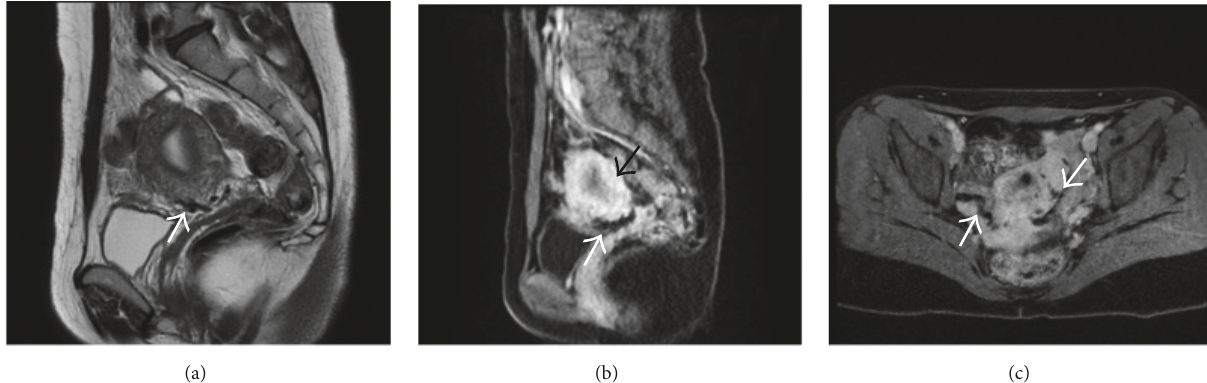
Figure 3: Postoperative MR 30 days after the embolization. (a) T2-weighted MR in sagittal plane: uterine wall preservation with serpiginous Onyx-18cast(whitearrow)intotheleftuterineartery.((b)and(c))Contrast-enhancedT1-weightedMR,sagittalandaxialplanes,respectively: preserved uterine wall perfusion (black arrow in (b)) without enhancement of the uterine arteries because of the Onyx-18 embolization (white arrows in (b) and